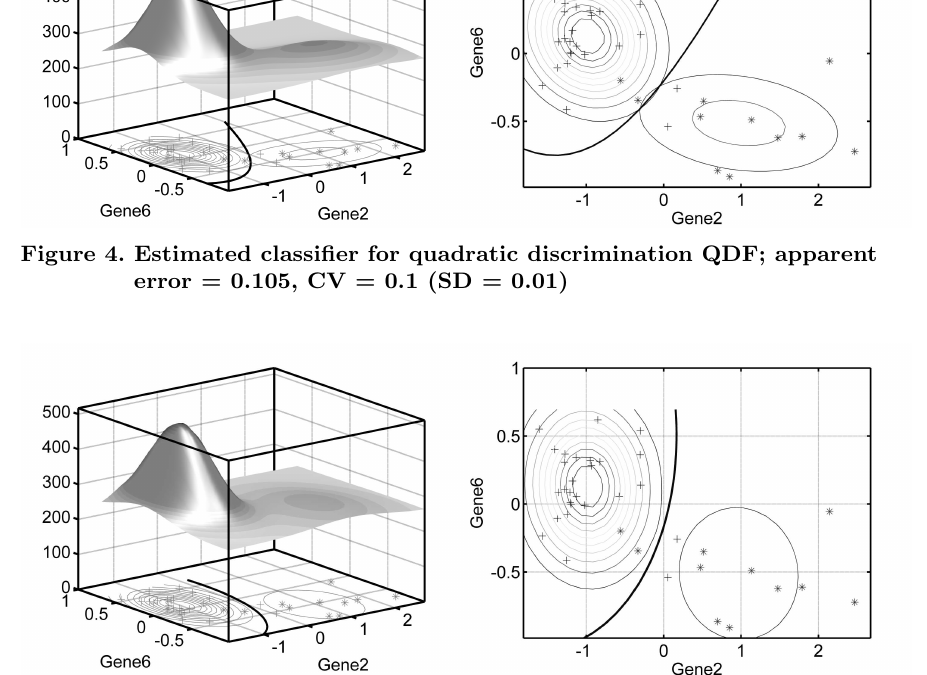
Figure 5. RQDF regularized with parameters error = 0.105, CV = 0.105 (SD <